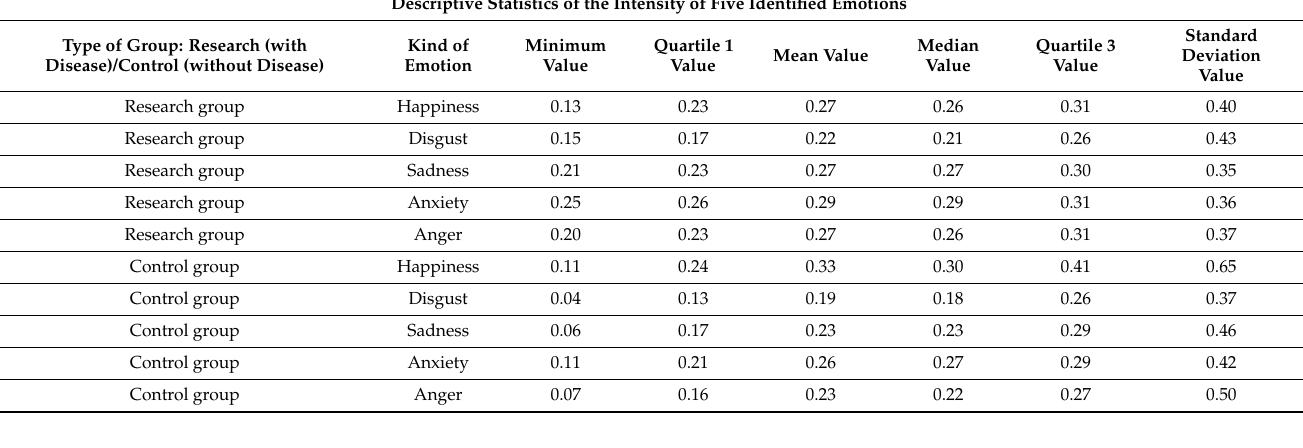
Figure 5. Correlation between measures in the group of healthy people.